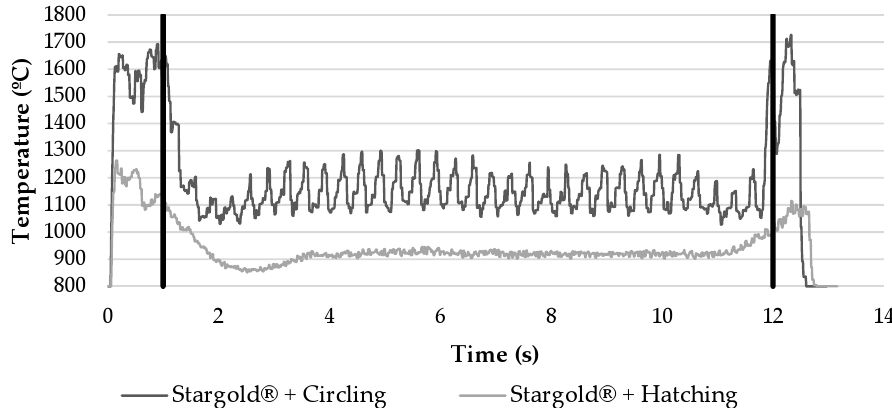
Figure 14. Nineteenth layer temperature representation for Stargold ® shielding gas at 30 L/min gas flow.